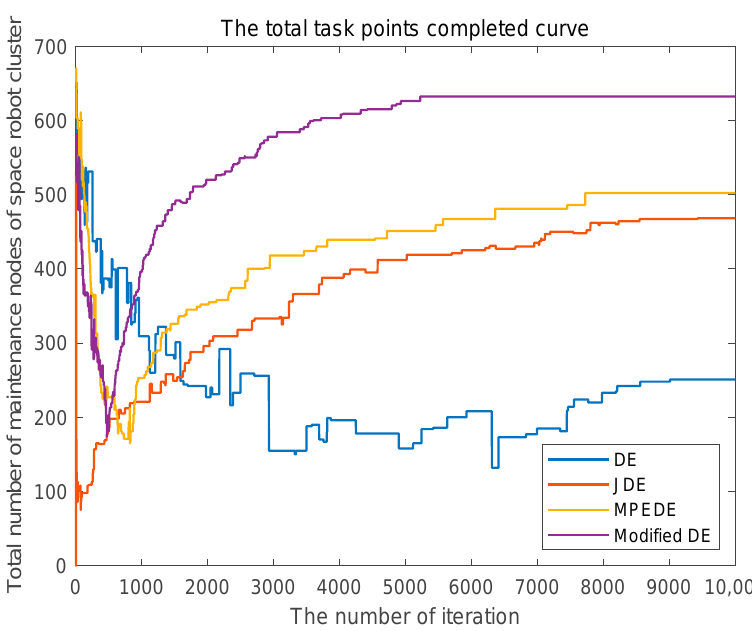
Figure 7. Total task points completed when the space-robot cluster energy is 6000.